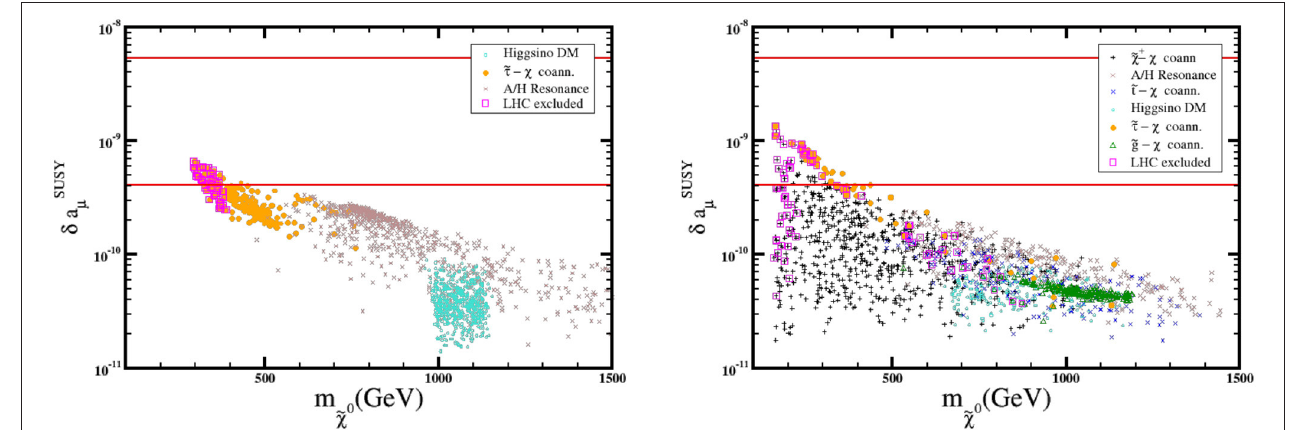
FIGURE 1 | Prediction for δ a SUSY µ vs. m χ . The red lines denote the 3- σ bounds for the experimental discrepancy of a µ with respect to the SM prediction. The left plot corresponds to SO(10) and the right to 4-2-2. Different symbols and color codes are assigned to each class of models and this notation is maintained in the rest of the plots as well: Turquoise dots stand for Higgsino DM, black crosses for coannihilations, orange dots for